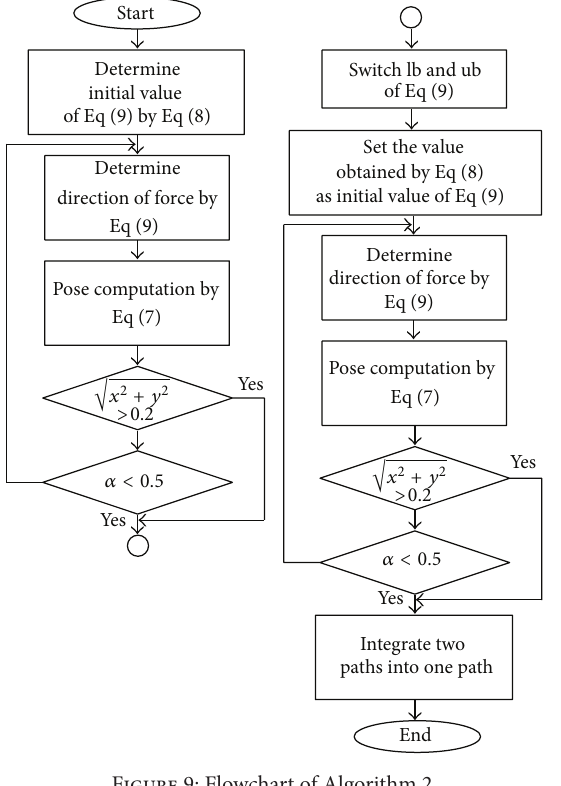
Figure 9: Flowchart of Algorithm 2.